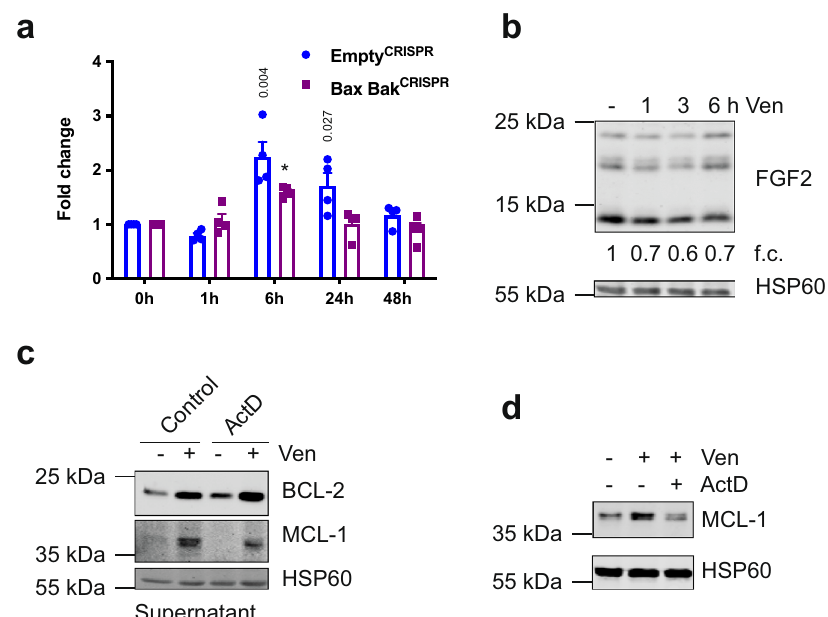
Fig. 5 Non-cell autonomous upregulation of BCL-2 proteins is independent of transcription. a HeLa tBID2A cells were treated with 500 nM venetoclax for the indicated time, RNA was harvested and expression of FGF2 mRNA analysed by qPCR. n = 4 independent experiments; mean values ± s.e.m.; * p < 0.0001; unpaired, two-sided t -test. b HeLa tBID2A cells were treated with 500 nM venetoclax for the indicated time, harvested and protein expression analysed by western blot. Fold change normalised to loading control is stated below (representative blot of three independent repeats). c HeLa tBID2A cells were treated with venetoclax ± actinomycin D for 3 h, followed by 45 h incubation in regular medium. Then the supernatant was harvested, fi ltered and added onto recipient cells. After 48 h, recipient cells were harvested and protein expression analysed by western blot (representative blot of three independent repeats). d HeLa tBID2A cells were treated with venetoclax for 3 h, followed by 45 h incubation in regular medium. Then the supernatant was harvested, fi ltered, supplemented with actinomycin D as indicated and added onto recipient cells. After 3 h, recipient cells were harvested and protein expression analysed by western blot (representative blot of three independent suf fi cient for non-cell autonomous upregulation of anti-apoptotic BCL-2 proteins.